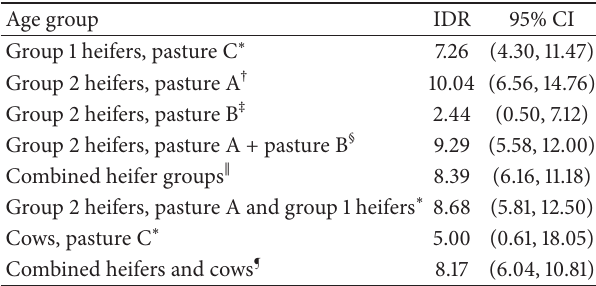
Table 5: Summary of incidence density rate (IDR) per 1000 cow- days for three cohorts of California beef cattle followed up for A. marginale infection by age group/pasture exposure, age group, and stage of maturity.